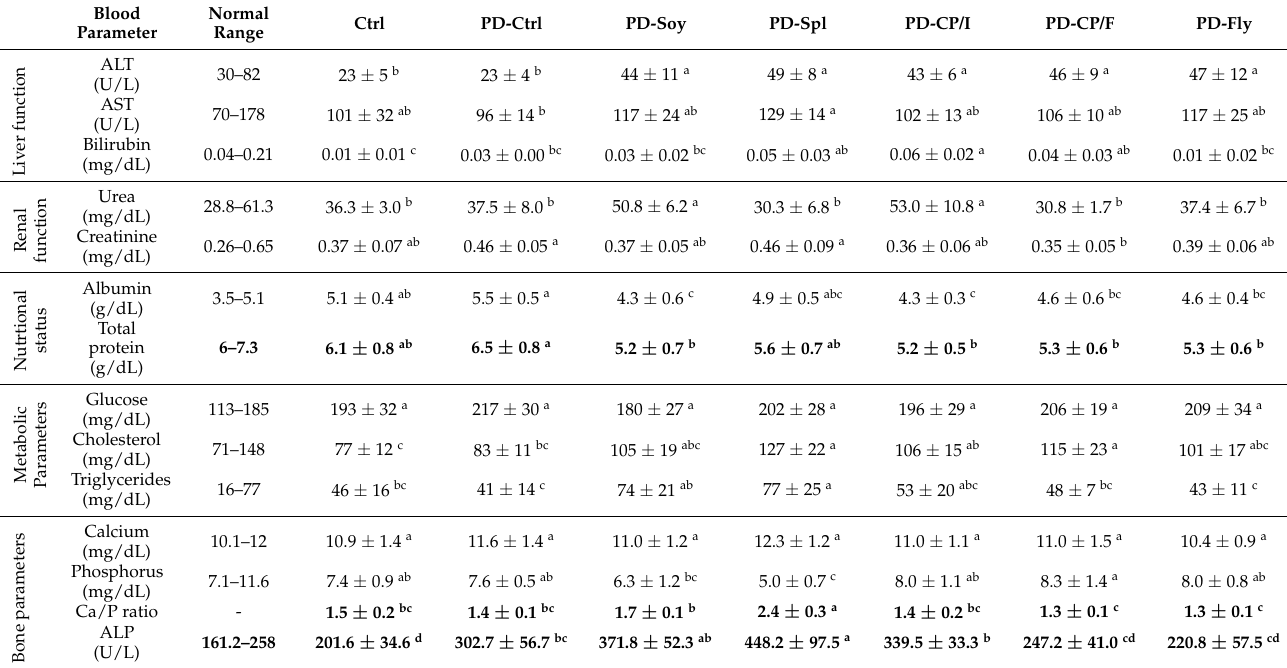
Table 3. Serum biochemistry analysis. ALP, Alkaline Phosphatase; ALT, Alanine Transaminase; AST, Aspartate Aminotransferase. Values are expressed as mean ± SD of n = 8 rat/group, different superscript letters are significantly different ( p < 0.05) by one-way ANOVA followed by Tukey’s test. Bold numbers significantly differ between diets and from the normal